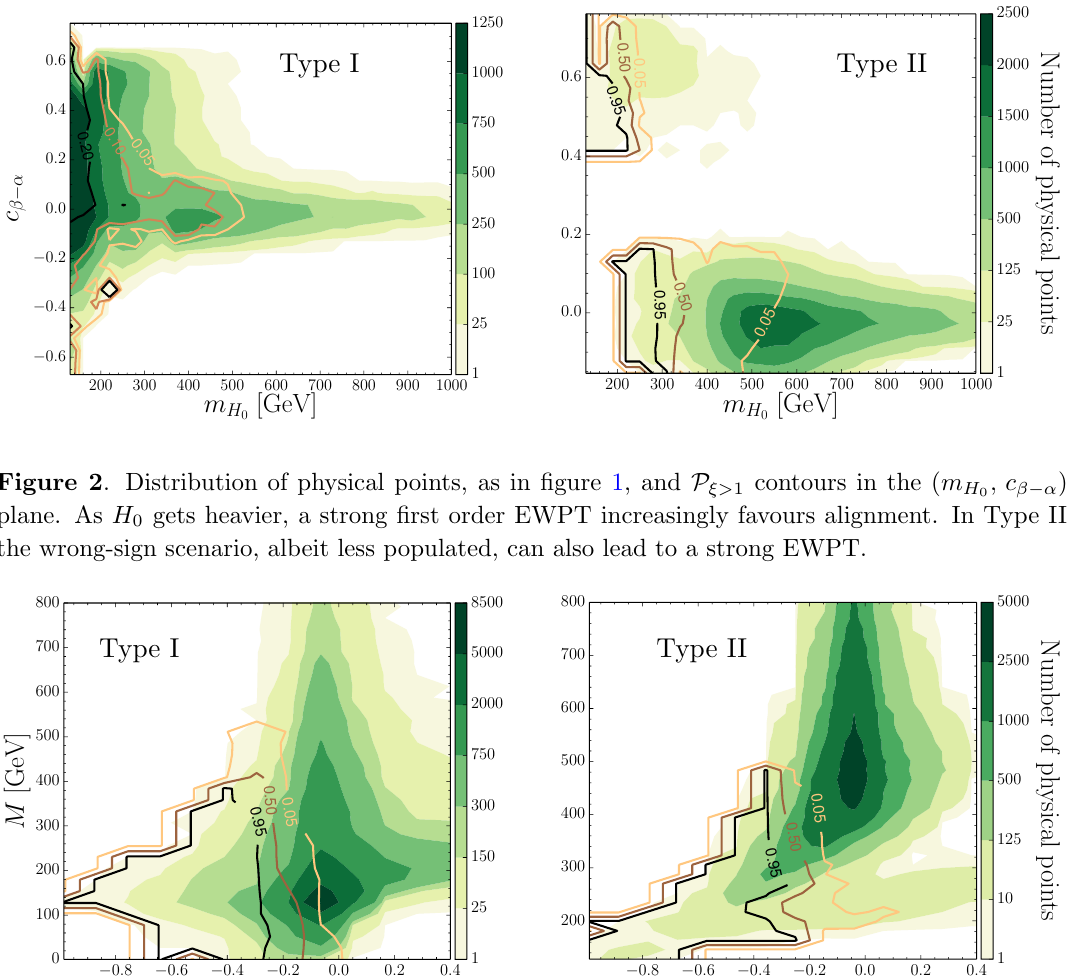
contours in the P (cid:24)> 1